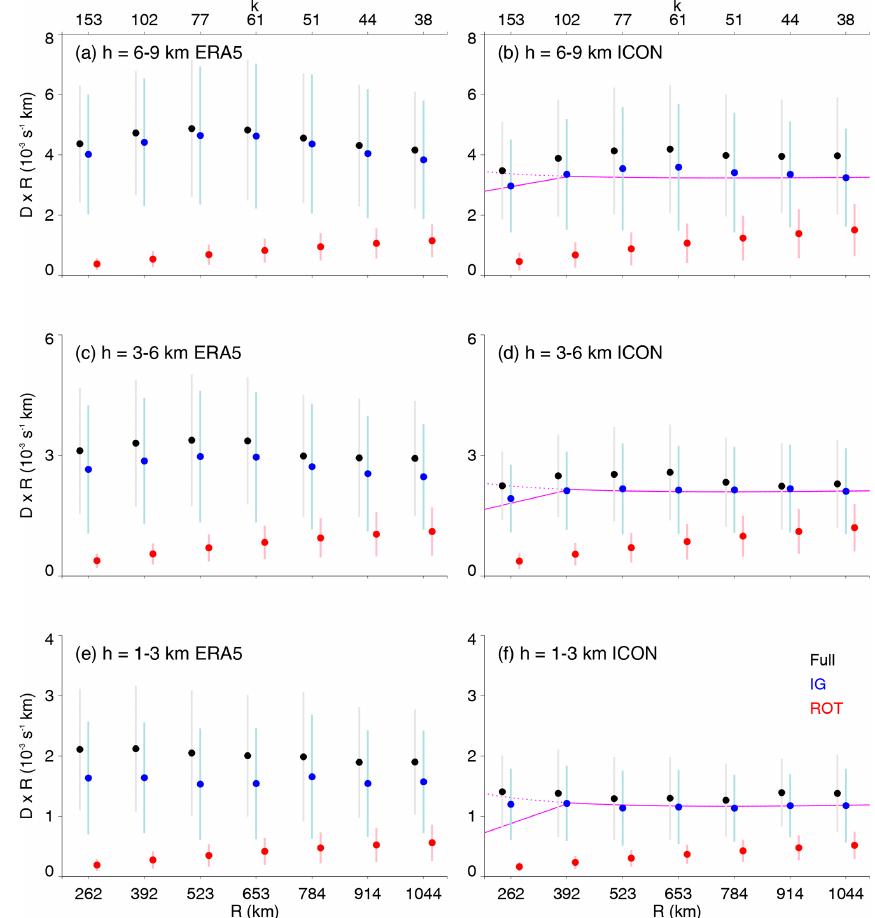
Figure 6. Divergence amplitude anomaly (defined as maximum minus minimum at (a) 6–9km, (b) 3–6km, and (c) 1–3km altitude) in (a, c, d) ERA5 and (b, d, f) ICON. The vertical lines mark ± 1 standard deviation. The solid magenta lines in panels (b, d, f) are theoretical predictions based on the spectra shown in Fig. 7 (see the text for details). The dashed magenta line uses a spectral slope of k − 5 / 3 instead of k − 2 at k > 100.